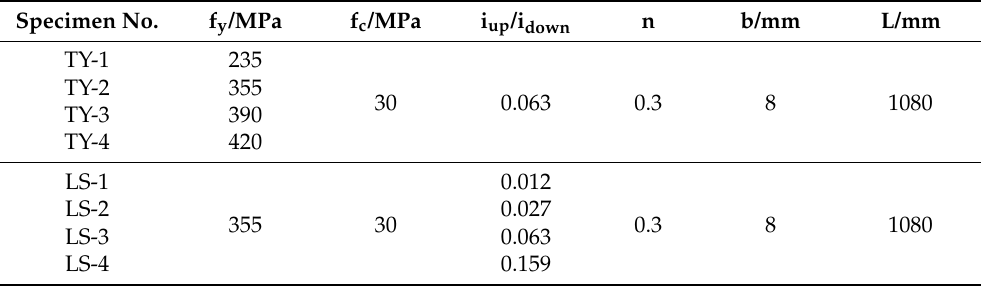
Table 12. Specific settings of the variable parameters of the USCFST-LCCFSE column connection components.